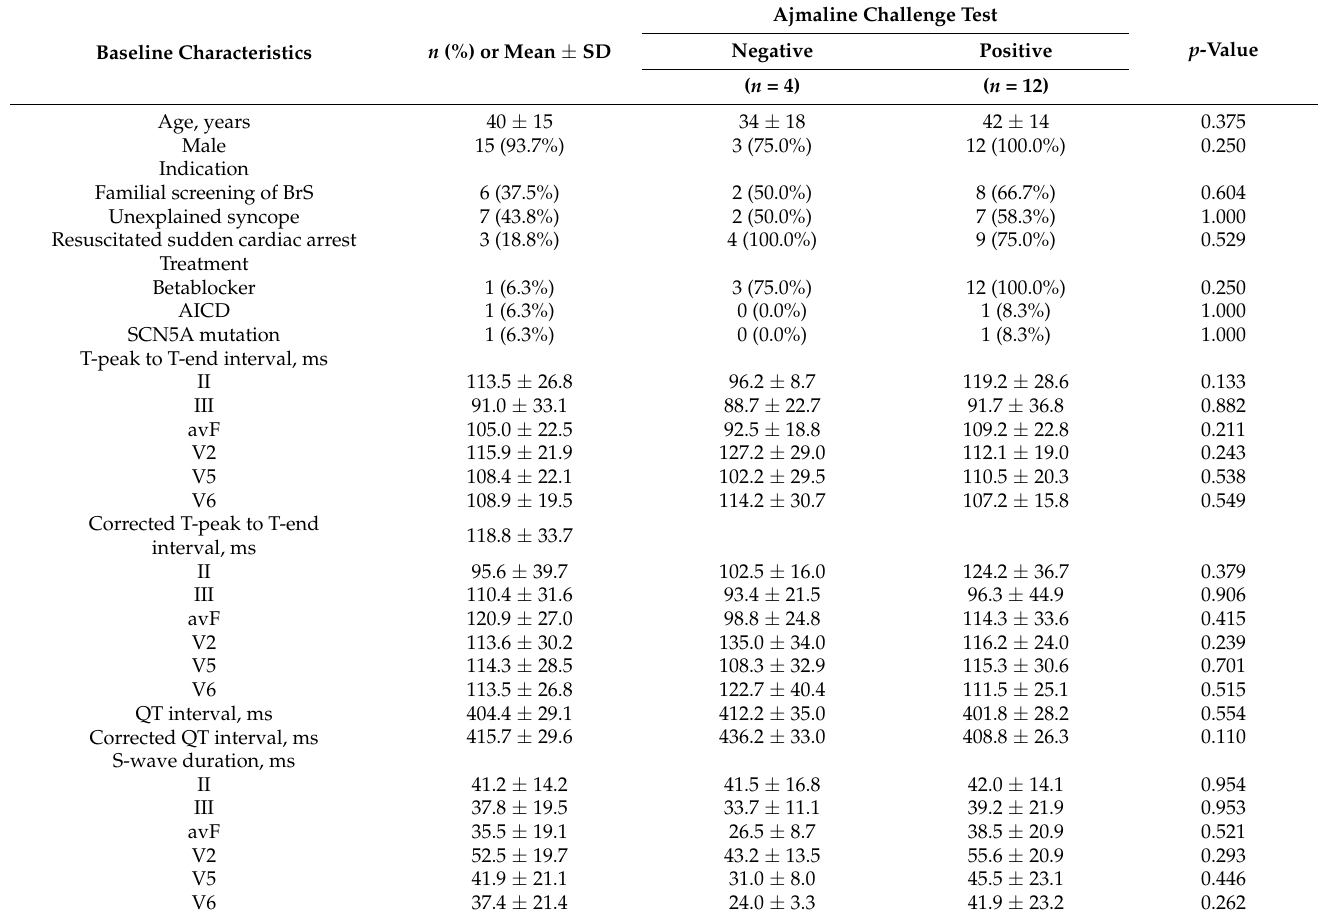
Table 1. Baseline Characteristics.